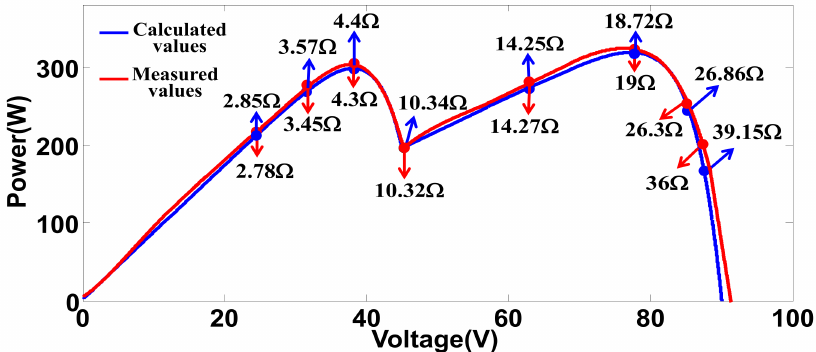
Figure 5. Comparison of calculated and measured P-V characteristics of two PV modules connected in series under 0–150 Ω load conditions and irradiance condition of S = 1000 and 500 for the two modules,